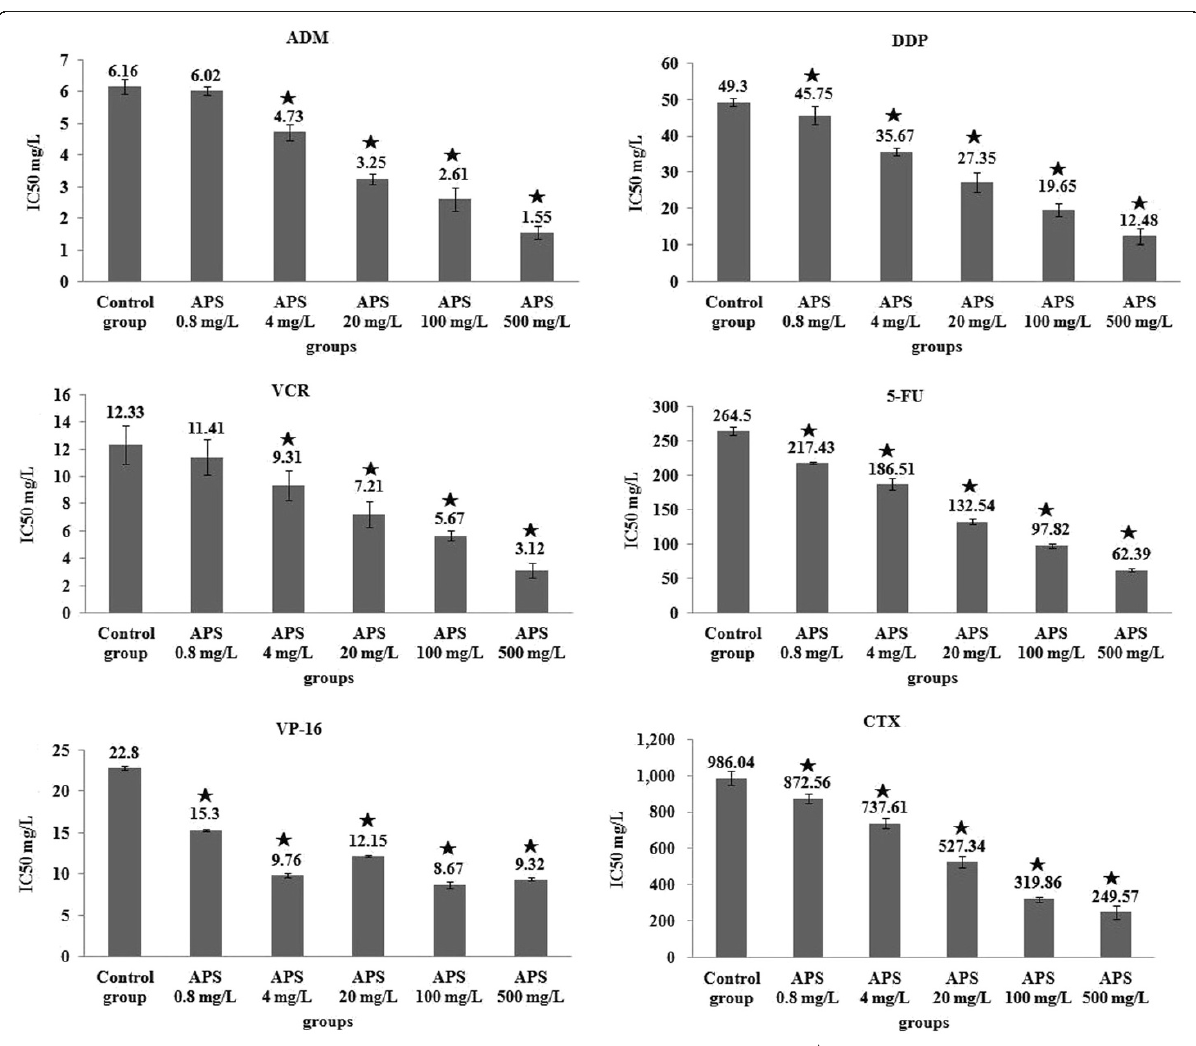
Figure 1 IC50 of APS combined with ADM, DDP, VCR, 5-FU, VP-16 or CTX in H22/ADM cells. ★ P <0.05, vs. control